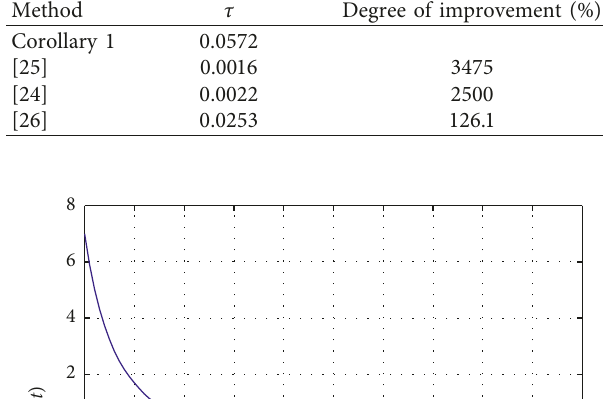
Figure 8: Fuzzy sampled-data controller u ( t ) .